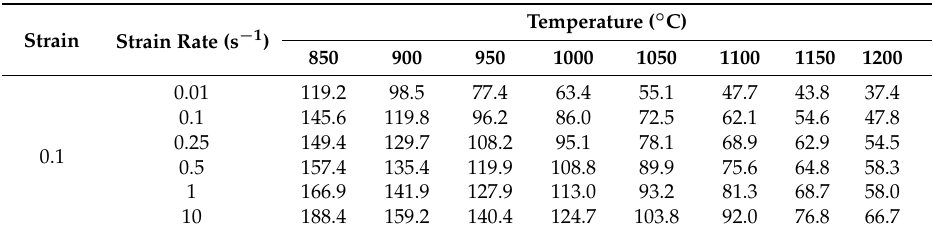
Table 1. Flow stress values (in MPa) of 25CrMo4 at different strain rates and temperatures for various